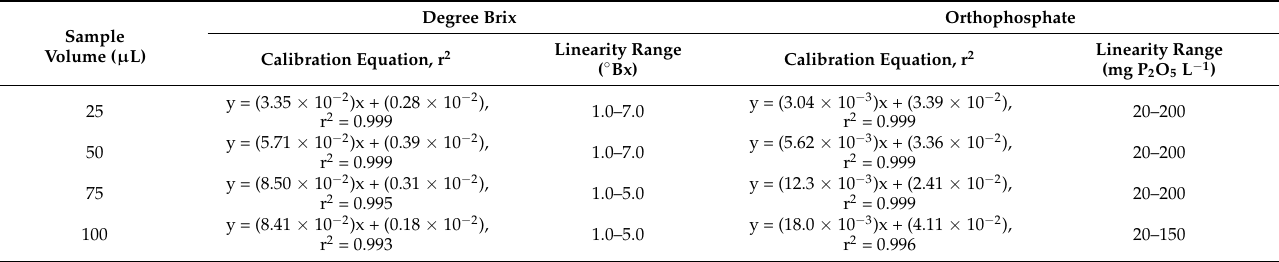
Table 2. Effect of sample volume for the analysis of degree Brix and orthophosphate in sugarcane juice. Sample Volume ( µ L)